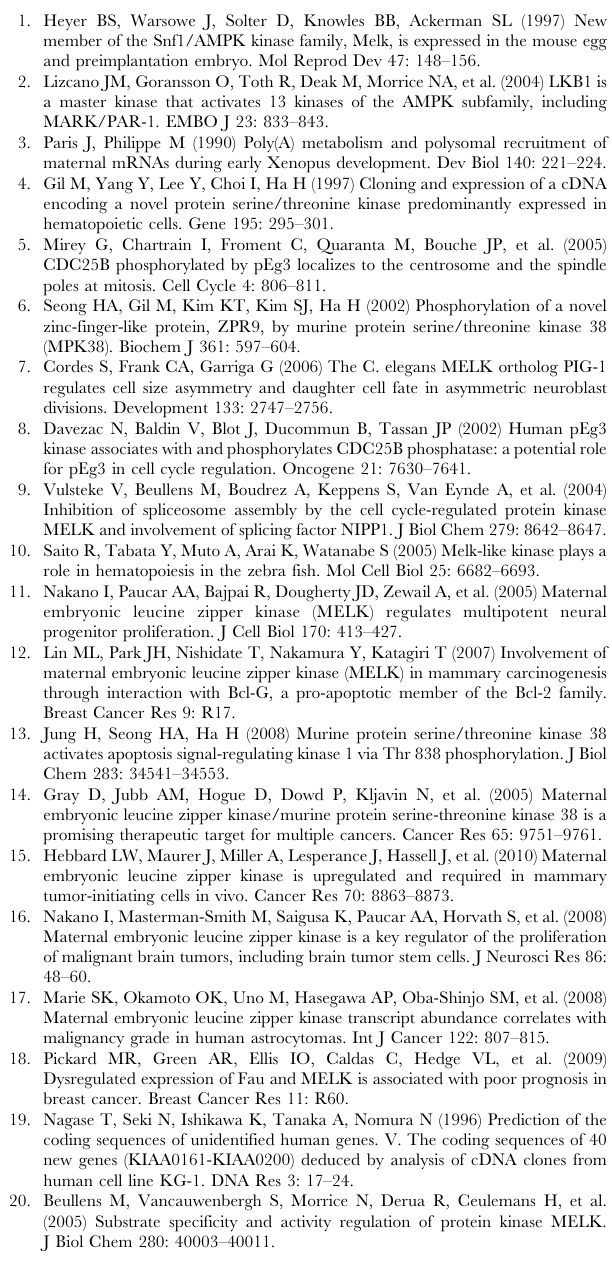
Figure S3 Sequence alignment of the kinase domains from hMELK, mMELK, xMELK, zMELK, cePIG1 and hMARK1-4. Figure S4 Circular dichroism (CD) spectra for MELK wildtype and two representative mutants. Figure S5 The C- and R-spines in the reported MELK structure (4BL1). Figure S6 Electron density map of the intermolecular disulfide